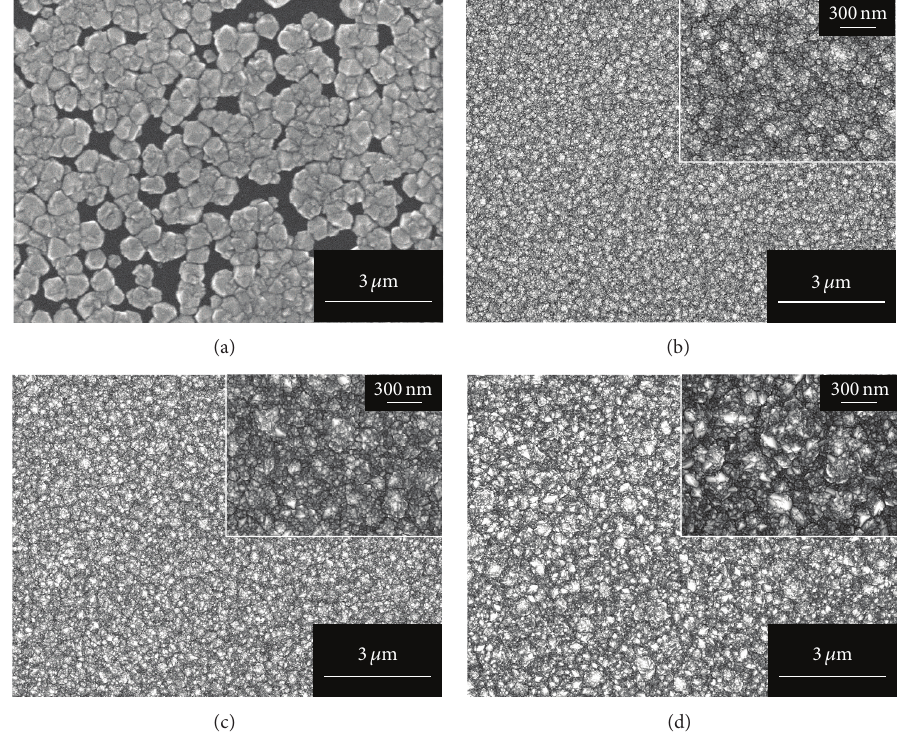
Figure 1: SEM images for the diamond films grown at various working pressures under (a) 20 Torr, (b) 40 Torr, (c) 60 Torr, and (d) 80 Torr, respectively.